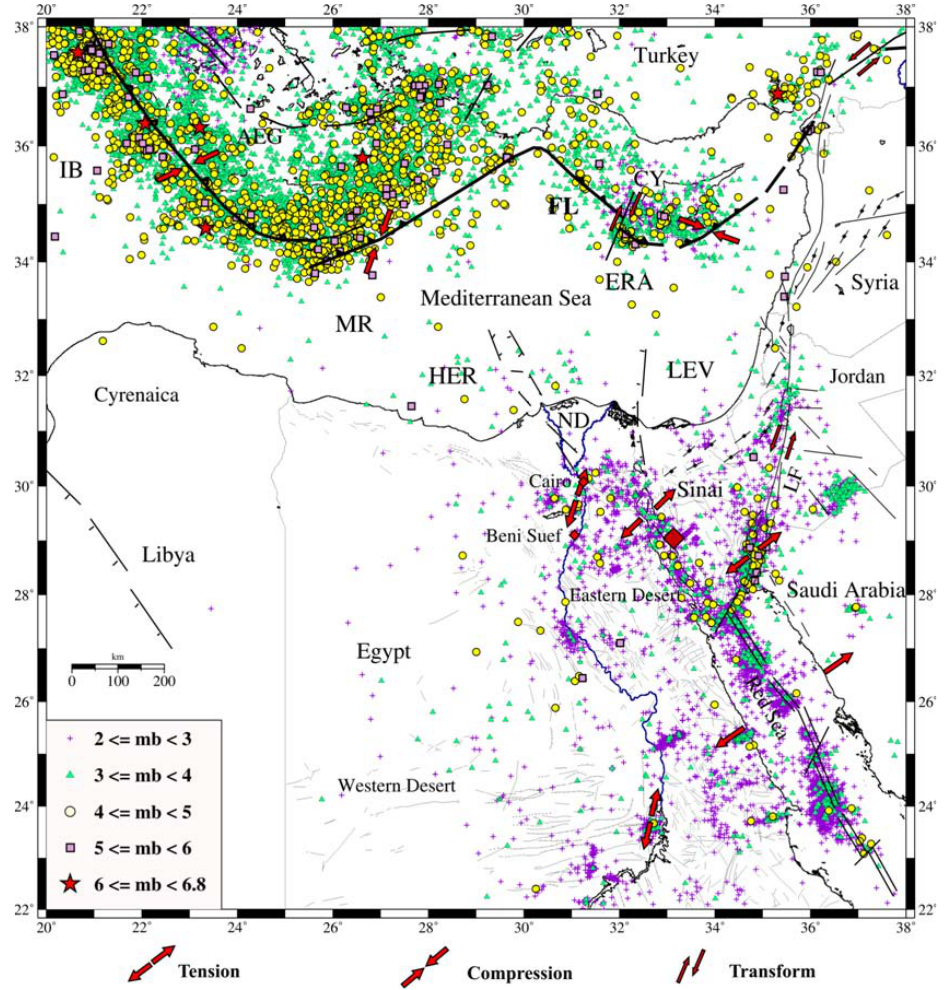
Fig. 3. Tectonic boundaries of the Eastern Mediterranean Region. Seismicity data (2 ≤ M b < 6.8) was compiled (Abou Elenean and Hussein, 2008) from ENSN and NEIC (1997–2007). The following Acronyms represent: AEG – Aegean Sea; Al – Alexandria City; CY – Cyprus; ERA – Eratosthenes Seamount; FL – Florence; IB – Ionian Basin; MR – Mediterranean Ridge; LEV – Levantine Basin; LF – Levant Fault; ND – Nile Delta. Red diamond indicates the location of Abo Zenema area. After Abou Elenean et al.